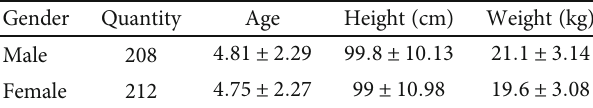
Table 1: The basic situation of the